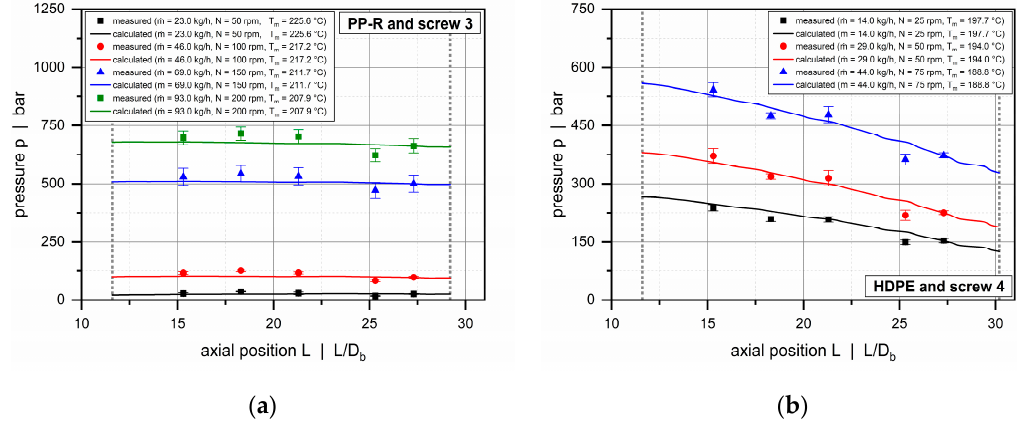
Figure 16. Comparison between experimental and calculated data for barrel 3. Axial pressure profiles along the wave zone for PP-R and screw 3 ( a ) and HDPE and screw 4 ( b ).